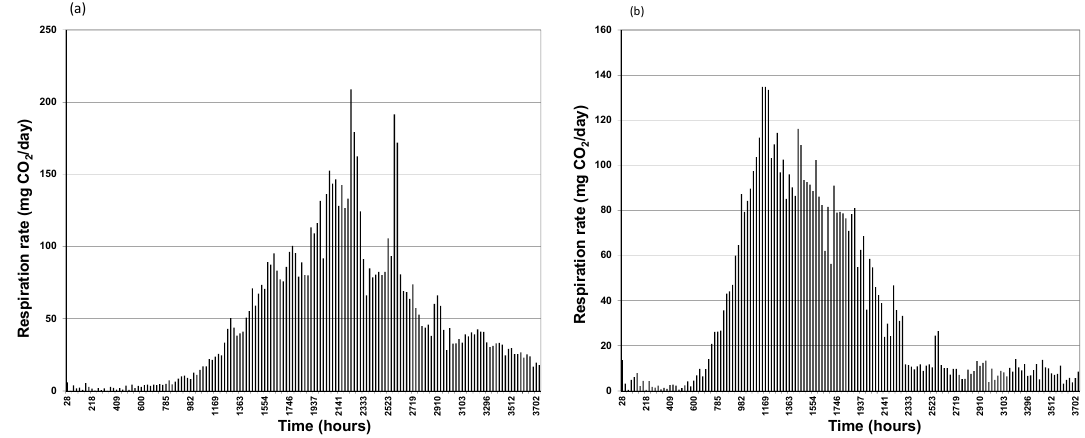
Figure 3. Instantaneous daily rates of CO 2 generation ( a ) Bio_Aug, ( b ) Bio_Avail.